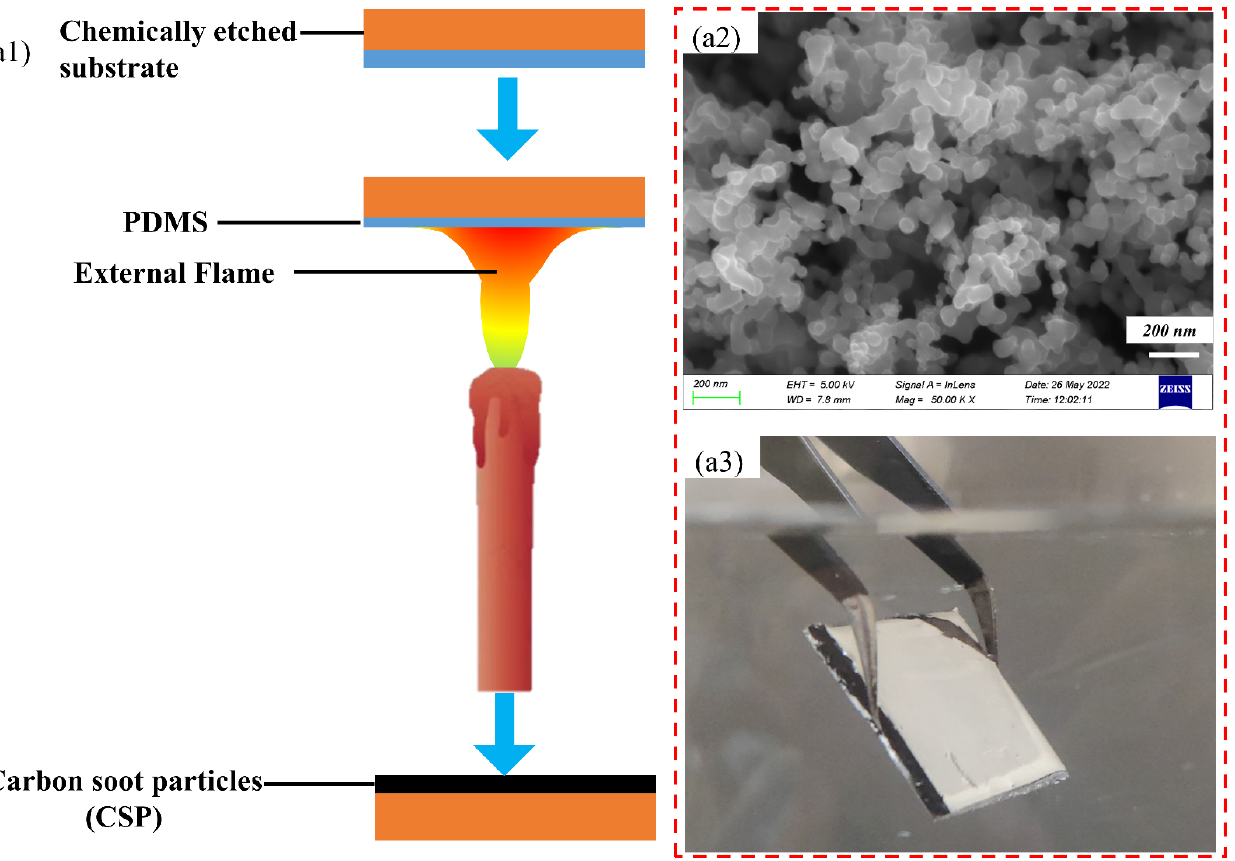
Figure 4. Preparation schematic diagram and the result of SC: ( a1 ) schematic diagram of deposited carbon soot particles by depositing hydrophobic carbon soot particles on the etched substrate; ( a2 ) microscopic morphology of superhydrophobic coating surface taken by Scanning Electron Micrscope; ( a3 ) image of silver mirror phenomenon of superhydrophobic coating.